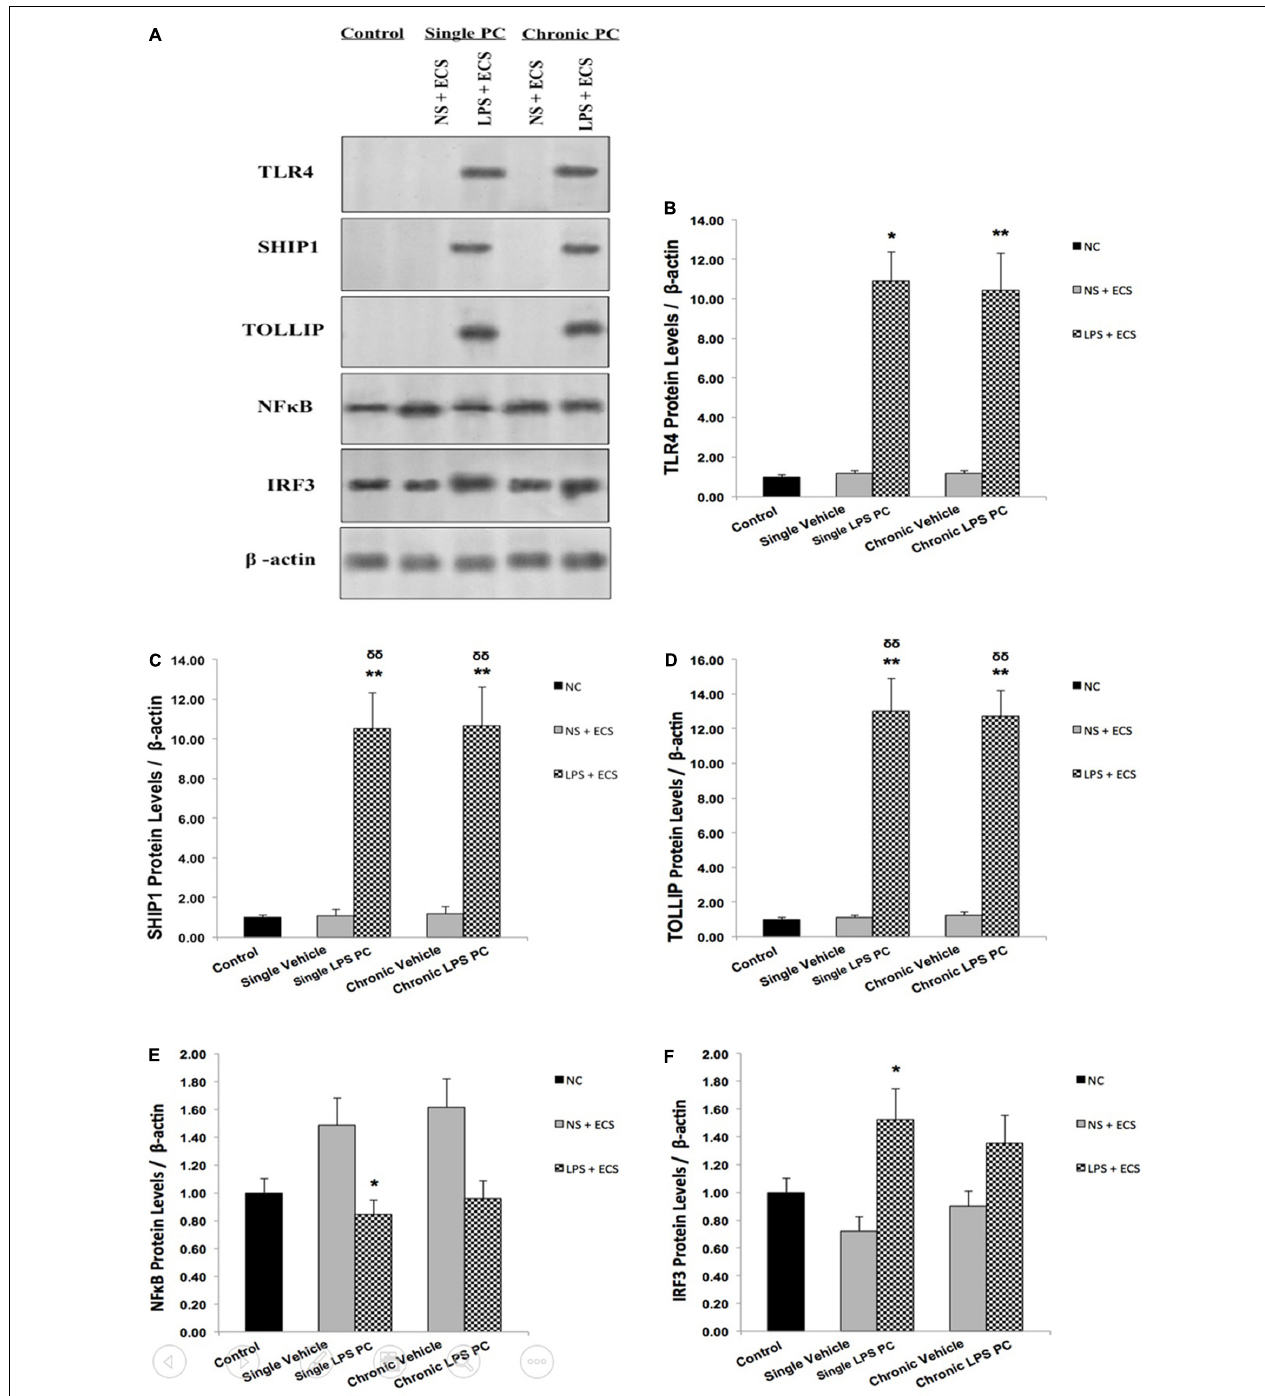
FIGURE 7 | The level of protein expression in the hippocampus of rat brain in ECS model of Epilepsy. (A) Representative western blots in the ECS model of epilepsy showing protein expression of TLR4, SHIP1, TOLLIP, NF κ B, and IRF3 in the hippocampus in control, single and chronic LPS-preconditioned, and vehicle groups. The graphs above display the effect of preconditioning by single low dose and chronic ultra-low dose of LPS on the protein expression level of (B) TLR4, (C) SHIP1, (D) TOLLIP, (E) NF κ B, and (F) IRF3 in the hippocampus in control, single and chronic LPS-preconditioned, and vehicle groups. Asterisk ( ∗ ) denotes a significant difference between the preconditioned groups and vehicle groups. Delta ( δ ) denotes a significant difference between the preconditioned groups and control groups. Statistical analysis was done according to the one-way ANOVA with significance levels of ∗ ρ < 0.05, ∗∗ ρ < 0.01; and δδ ρ < 0.01. Data are shown as mean ± SEM of three ( n = 3), which expressed as fold change relative to control group. ECS, electroconvulsive shock; NS, normal saline; LPS, lipopolysaccharide; PC, preconditioning; NC, no current was passed through the electrodes.